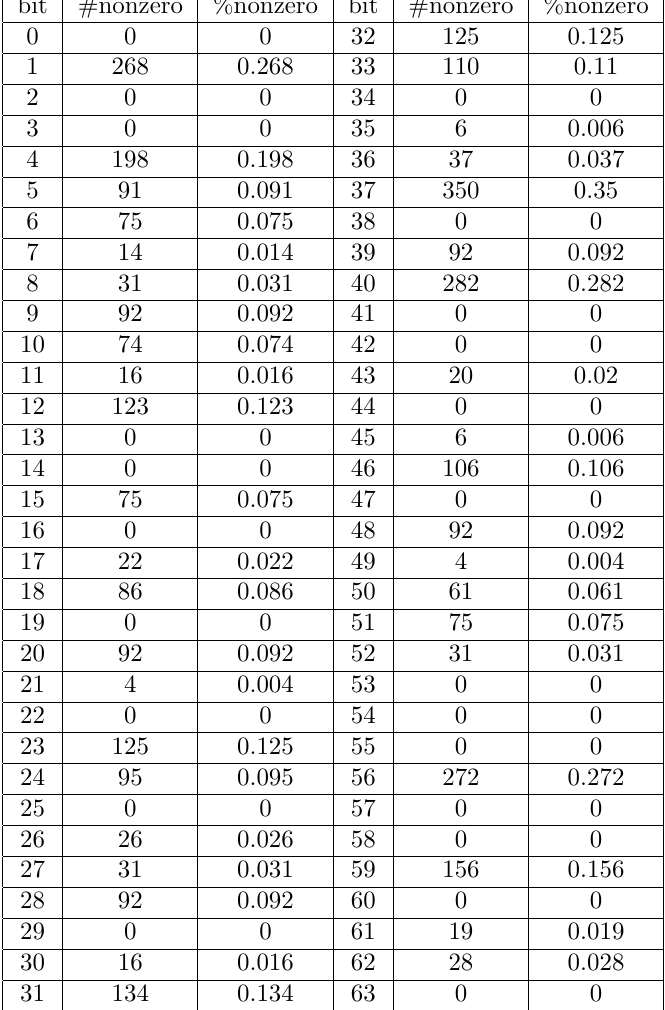
Table 9: Statistics of Nonzero Cube Sums in the 64-bit Output of 5-round Ascon